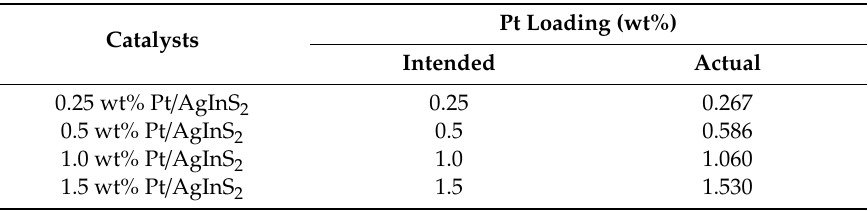
Table 6. The loading amount of Pt in the